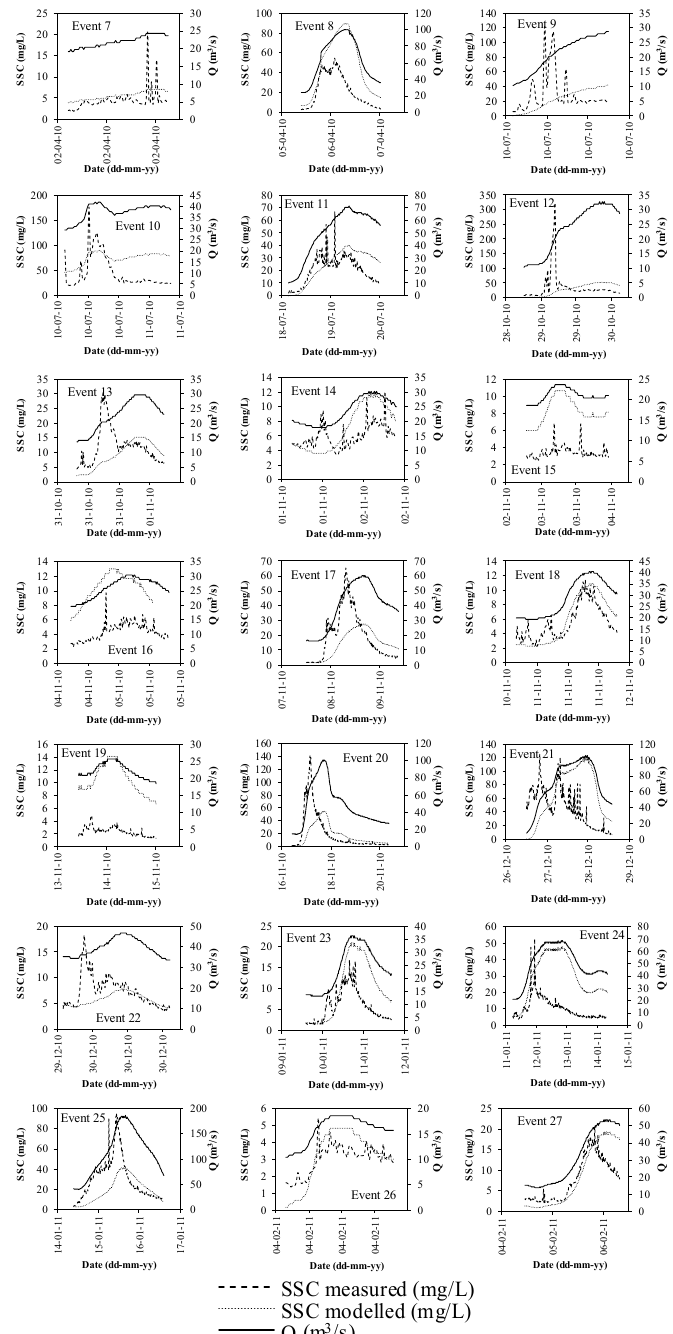
Figure 11. Measured and modeled suspended sediment concentration ( SSC ) concentration for the shear stress-based model.